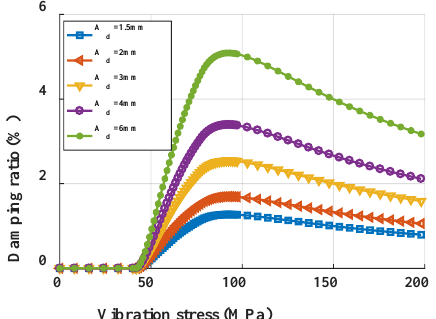
Figure 23. Damping characteristics at different section areas for labyrinth seal.